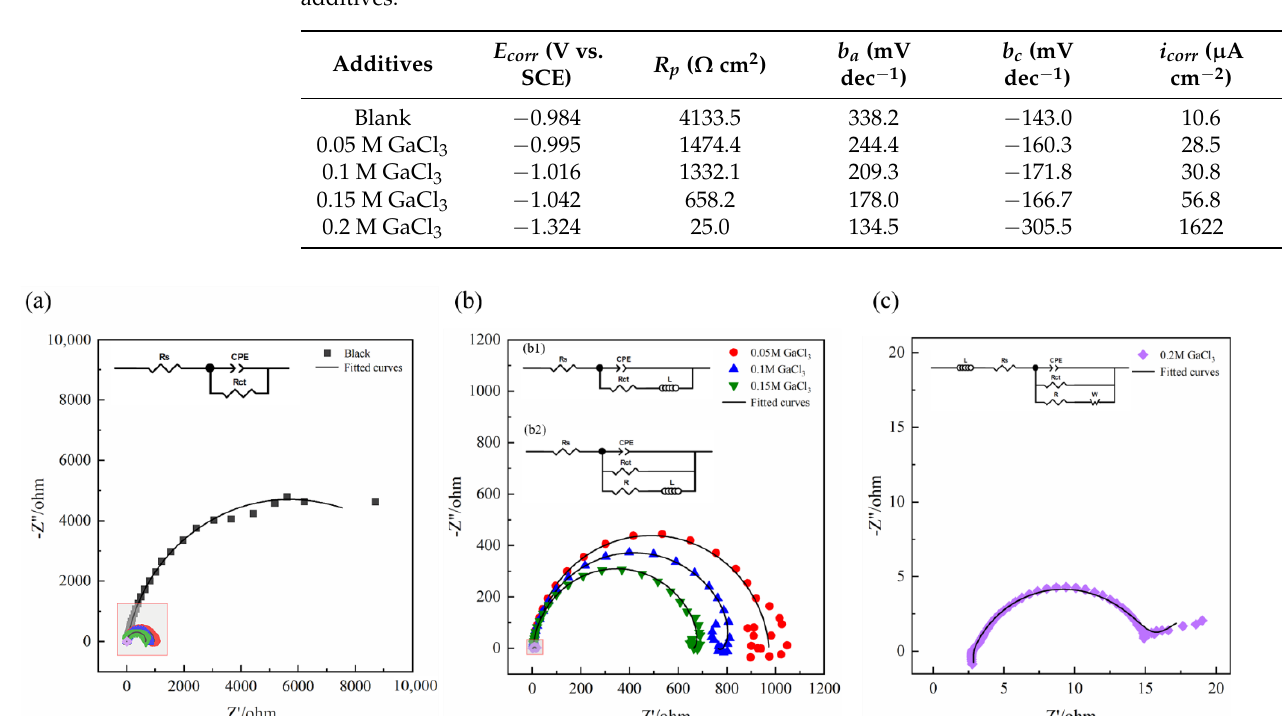
Figure 7. ( a ) Potentiodynamic polarization, ( b ) linear potentiodynamic sweep curves of Al in 2 M NaCl electrolyte without and with different content of additives. Table 3. Corrosion parameters of Al in 2 M NaCl electrolyte without and with different content of additives.